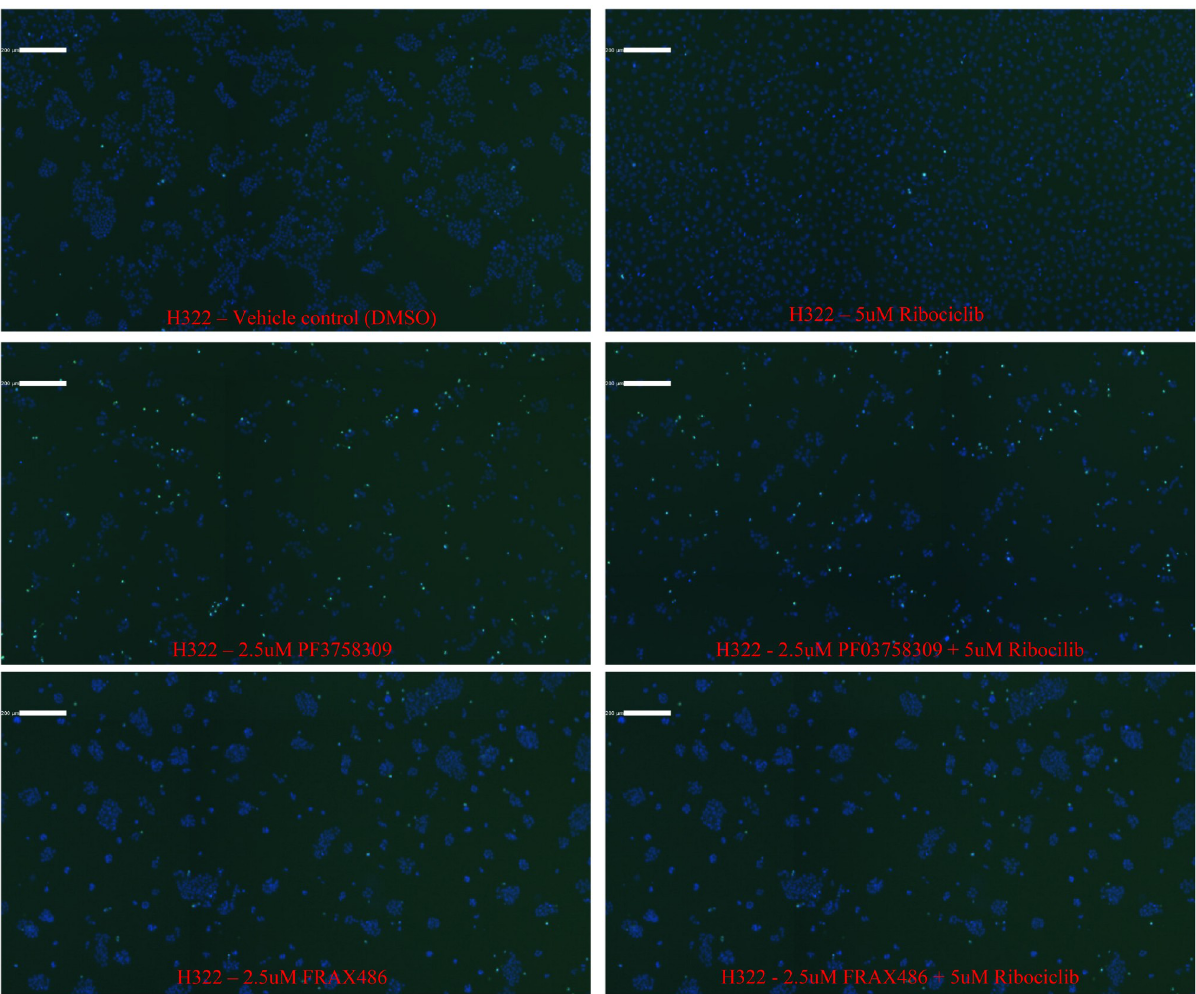
Fig 4. PF03758309 and its combinations induces apoptosis based on Celigo imaging. Colorimetric assay on a Celigo S (Nexcelom) showing apoptosis in H322 cells treated with vehicle control (DMSO), 2.5 μ M PF03758309, 2.5 μ M FRAX486 or 5 μ M Ribociclib as well, as the combinations. The cells were stained with Cyto-ID green, to detect Caspase 3/7 (green), and Hoechst, to detect the nuclei of the cells (blue), and images were captured with the Celigo